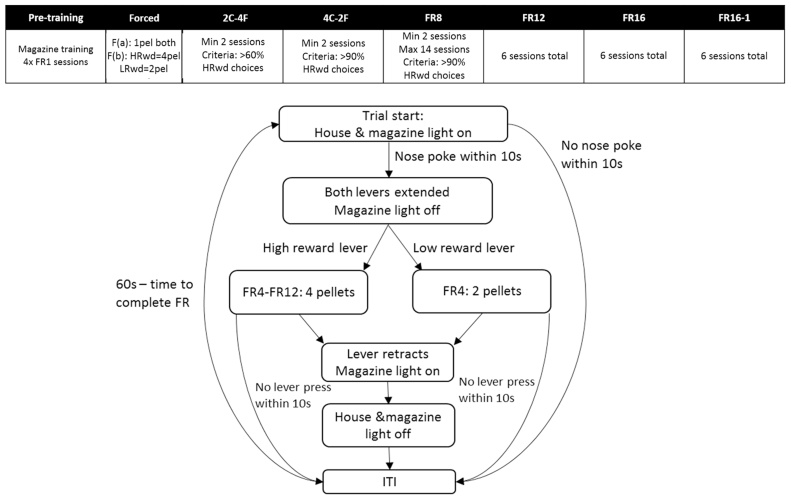
Cost-benefit task (Experiment 3). Schematic showing the order of all stages, and basic trial structure, of the cost-benefit task. Abbreviations: C = choice trials; F = forced trials; FR = fixed ratio.